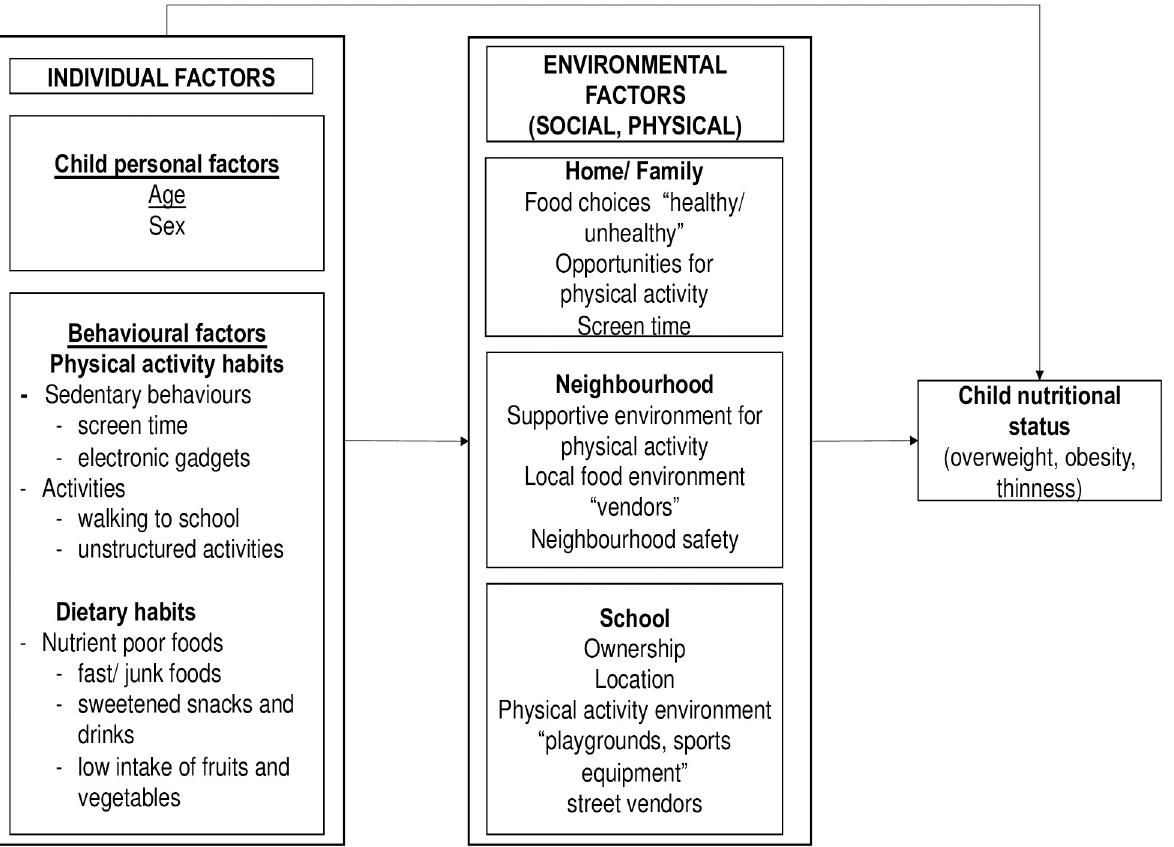
Fig 1. Socio-ecological model for childhood overweight and